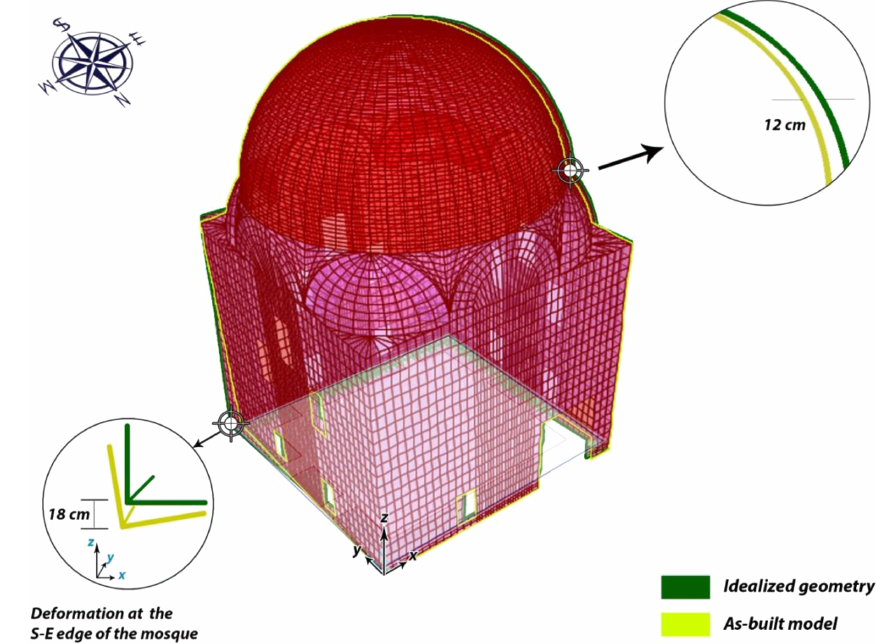
Figure 6. Deformation of the structure at the southeastern corner and east of the dome.